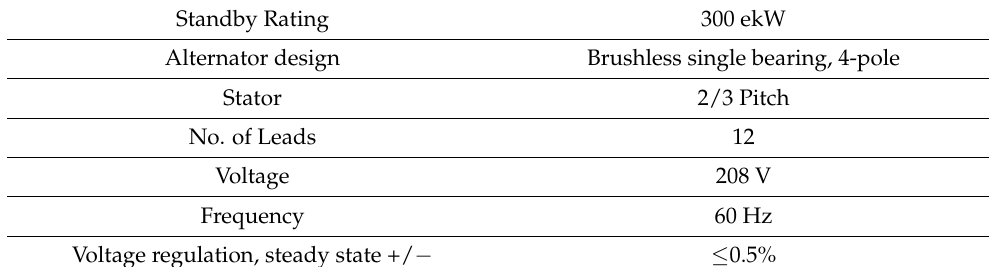
Table 4. Electrical generator specifications.